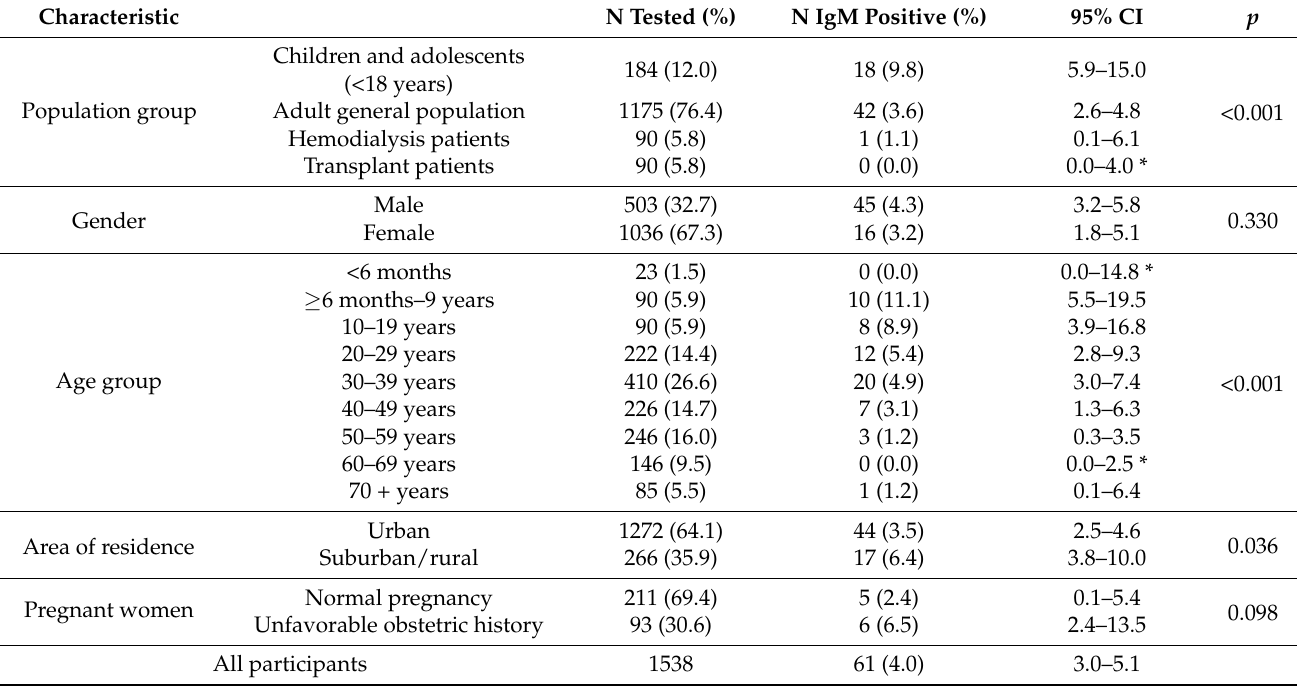
Table 2. Prevalence of parvovirus B19 IgM